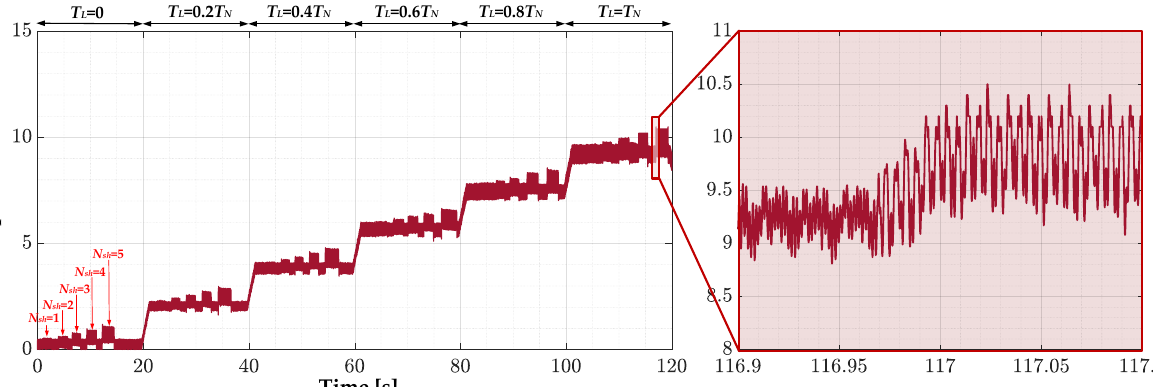
Figure 3. Effect of ITSCs in the PMSM stator winding on the waveform of the stator phase current space vector module, experimental study ( T L = var, f s = f sN = 100 Hz).